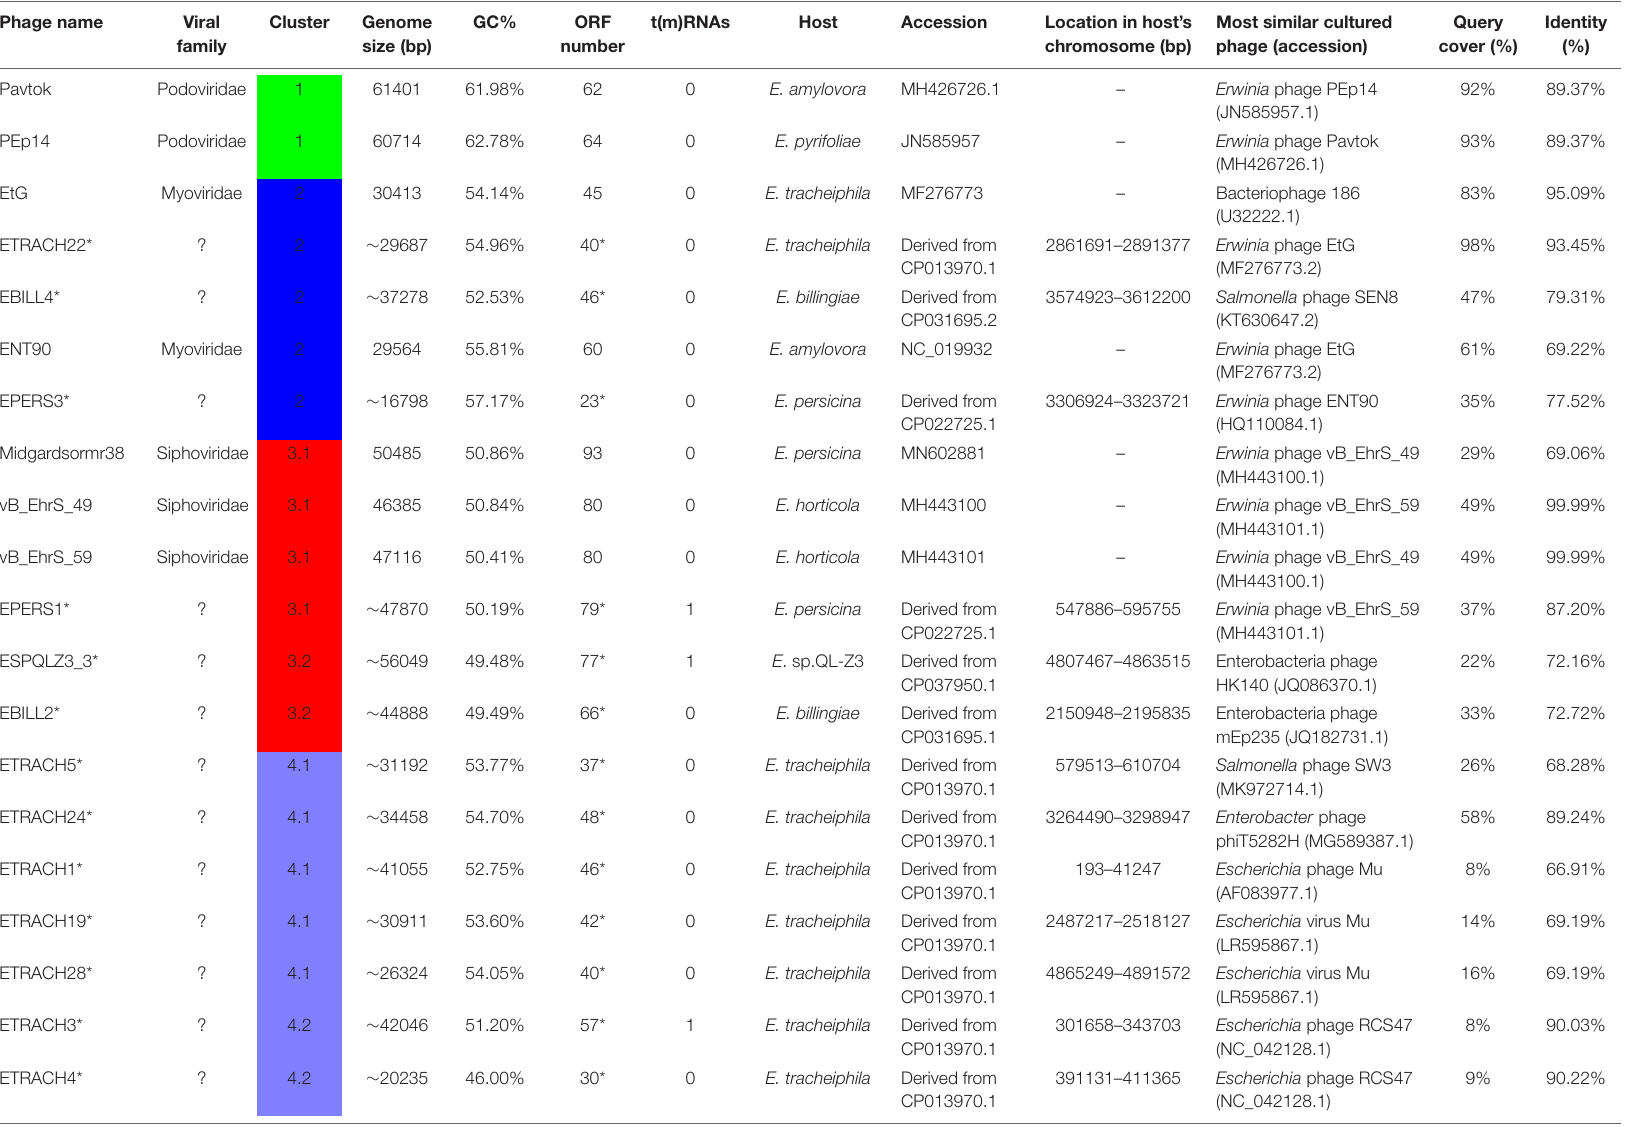
TABLE 2 | Overview of the analyzed Erwinia phages and